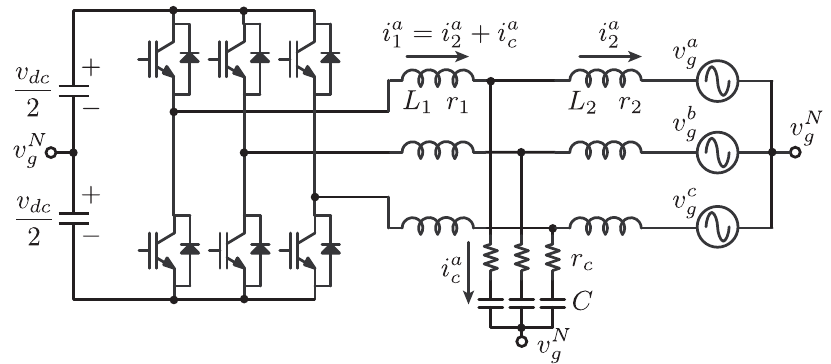
Figure 1. Transformerless three-phase grid-connected inverter with the LCL filter.